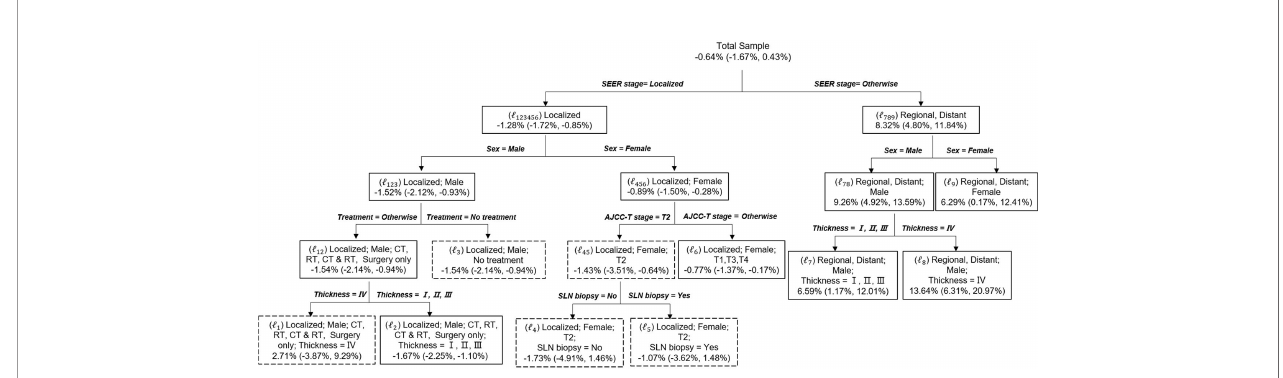
FIGURE 2 | Causal Tree of patients dying of CMM. The discovered tree was developed from the fi rst subsample and the risk difference and the 95% CI for each split subgroups calculated from the second subsample. The subgroups in solid rectangles represent a signi fi cant risk difference between solitary CMM and CMM with multiple tumors, whereas dashed rectangles indicate no signi fi cant difference. Risk difference was calculated as the probability of death for solitary CMM minus the probability of death for CMM with multiple tumors. Age: young ( ≤ 45 years), middle (45 – 60 years), and old